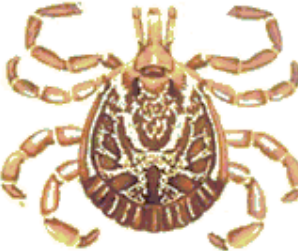
Figure 2. Amblyomma cajennense , the main species in the transmission of Brazilian spotted fever